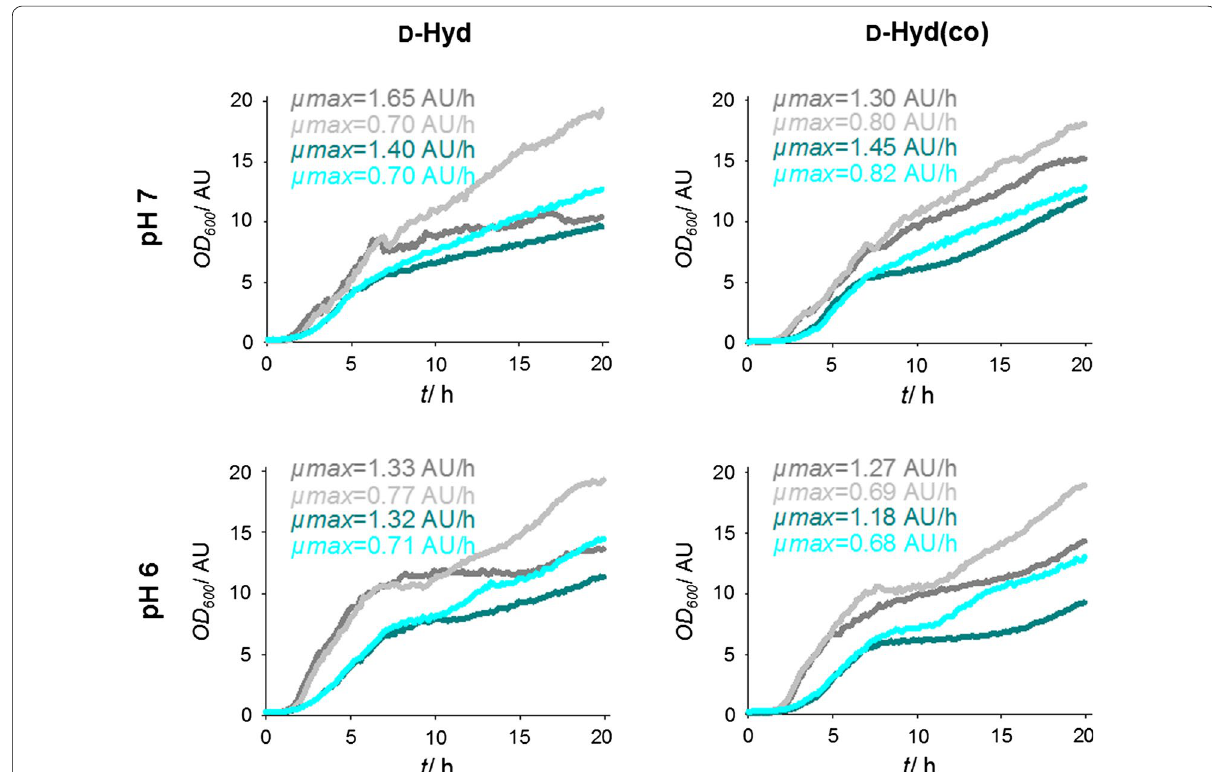
Fig. 4 Screening for cultivation conditions of E. coli BL21DE3 expressing d -Hyd and d -Hyd(co). Growth curves and maximum growth rates under dif- ferent cultivation conditions. -EtOH out in triplicates, shown are the mean